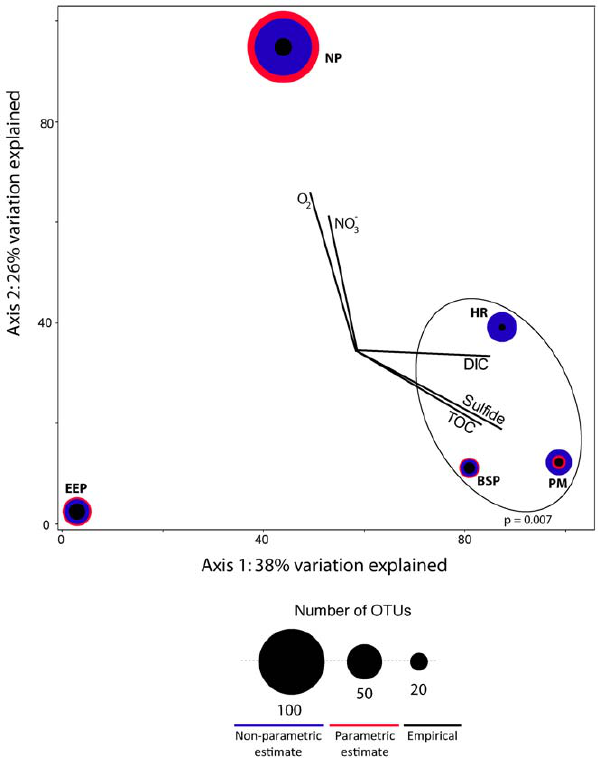
Figure 3. Canonical correspondence analysis of fungal OTUs from marine subsurface samples. Black circles are proportional to the number of fungal OTUs detected in each sample. Red and blue circles are proportional parametric (CatchAll) and nonparametric (Chao1) richness estimates (see Table S2). Vectors represent sulfide, TOC, and DIC correlations. The p-value resulting from an MRPP test for effect of DIC, TOC, and sulfide on fungal distributions is shown in the lower right corner of the biplot. See Table 1 for sample information.